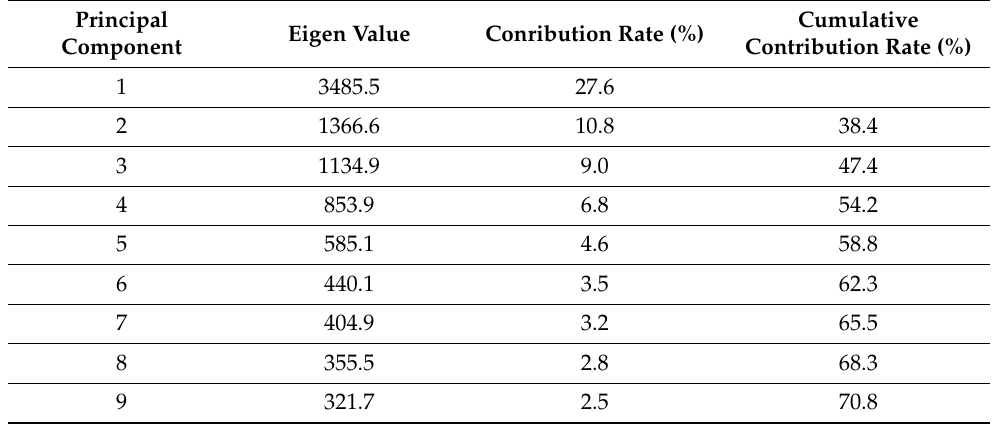
Table 5. Principal component in half